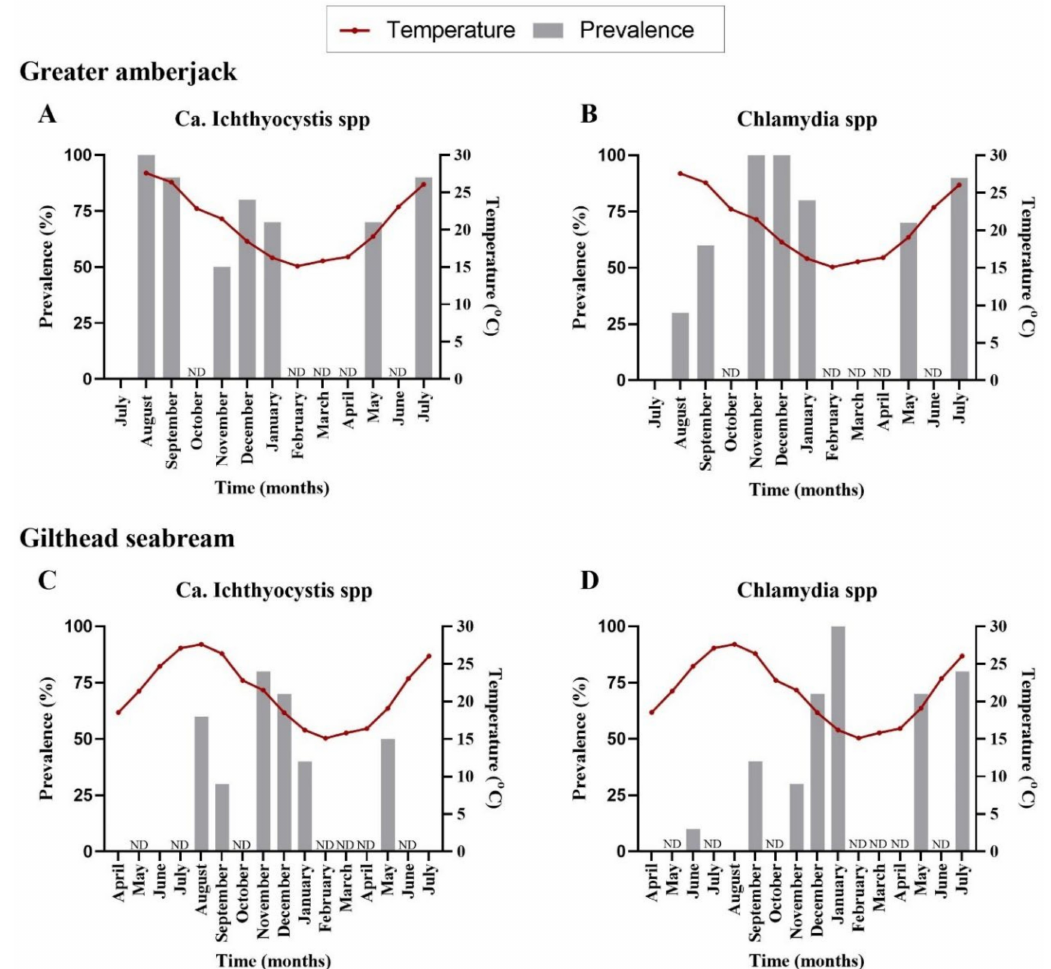
Figure 1. Prevalence of epitheliocystis agents in greater amberjack ( A , B ) and gilthead seabream (cohort 2018) ( C , D ). Water temperature is shown by the red line. ND (not determined) in the graphs marks months in which cohorts were not